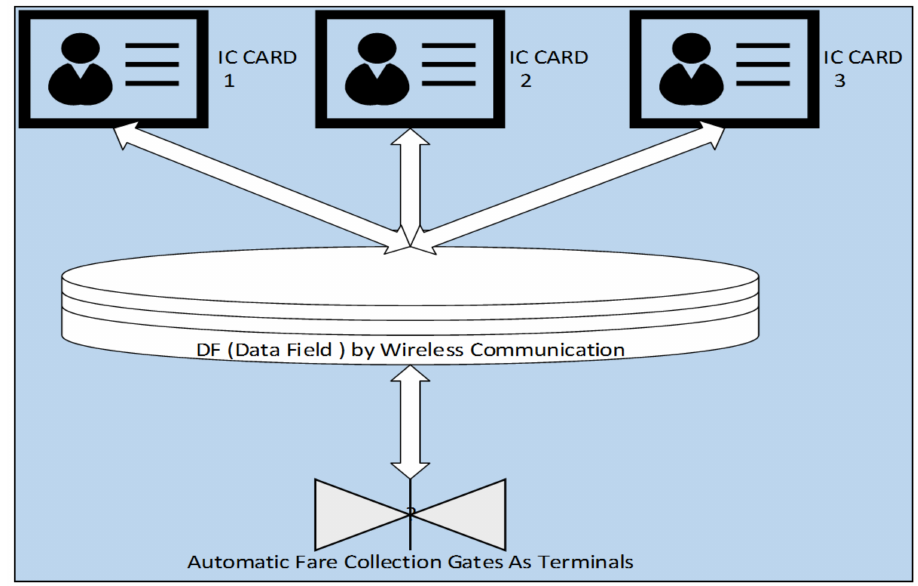
Figure 4. Data field between IC card and station in autonomous decentralised IC card system